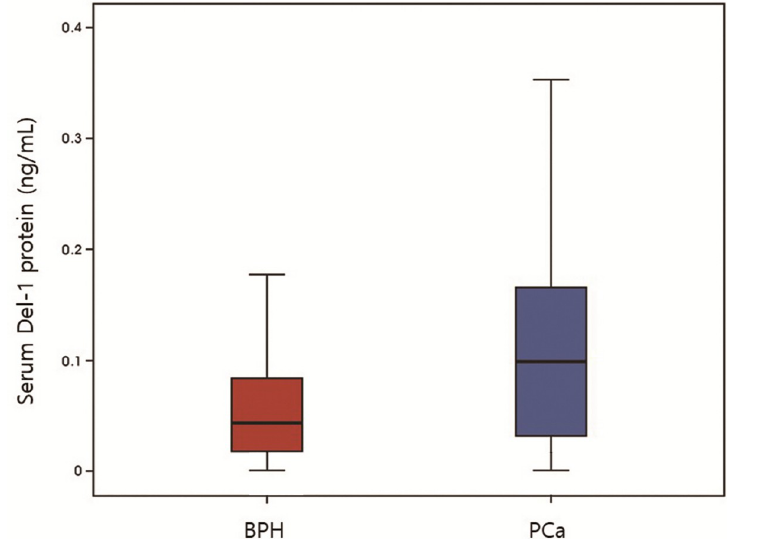
Fig 3. Basic characteristics of the patients (benign versus prostate cancer). PCa, prostate